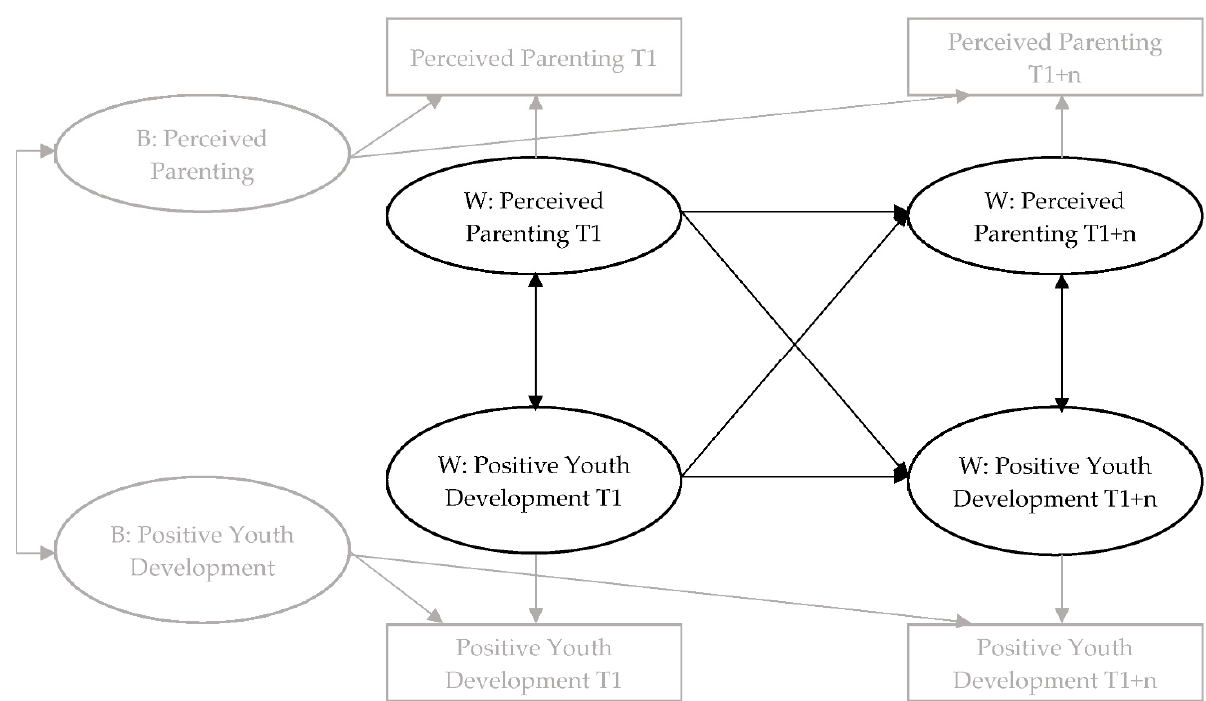
Figure 1. The conceptual and measurement model of mutually influential relationships. Note: The conceptual model is represented by black lines and the measurement model by black and grey together. The measurement model is the random intercept cross ‐ lagged panel model. W = Within ‐ person. B = Between ‐ person.